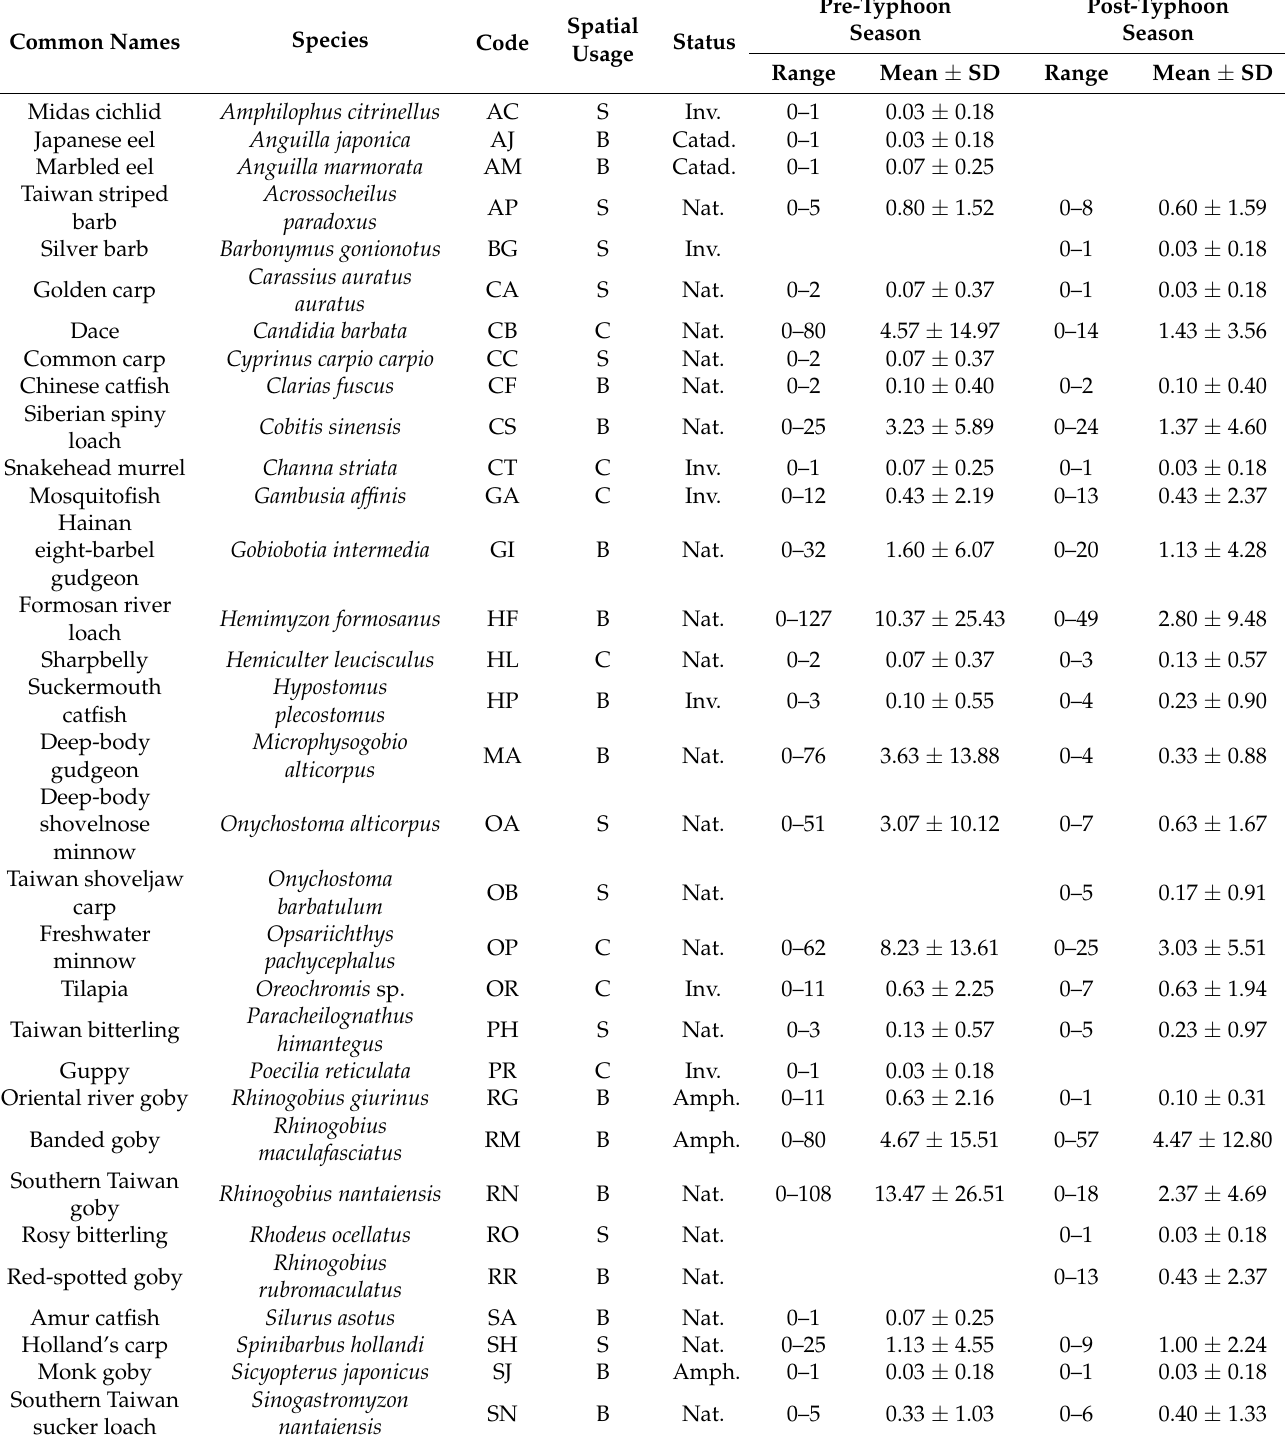
Table 3. Fish species, species codes, spatial preference in the water, status, and statistics of density (individuals/100 m) of fish captured in two seasons. For fish spatial usage, B is benthic, C is water column, and S is sub-benthic space. For fish status, Amph represents amphidromous, Catad. represents catadromous, Inv. represents invasive, and Nat. represents native